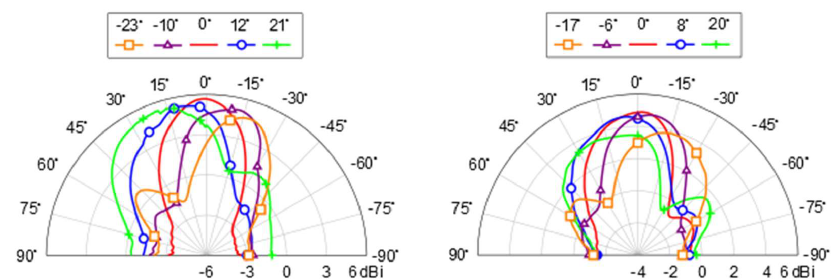
Figure 33. Measured antenna gain patterns in the E ( left ) and H ( right ) principal planes [170,175]. Reprinted from [2], Cambridge University Press, 2020.